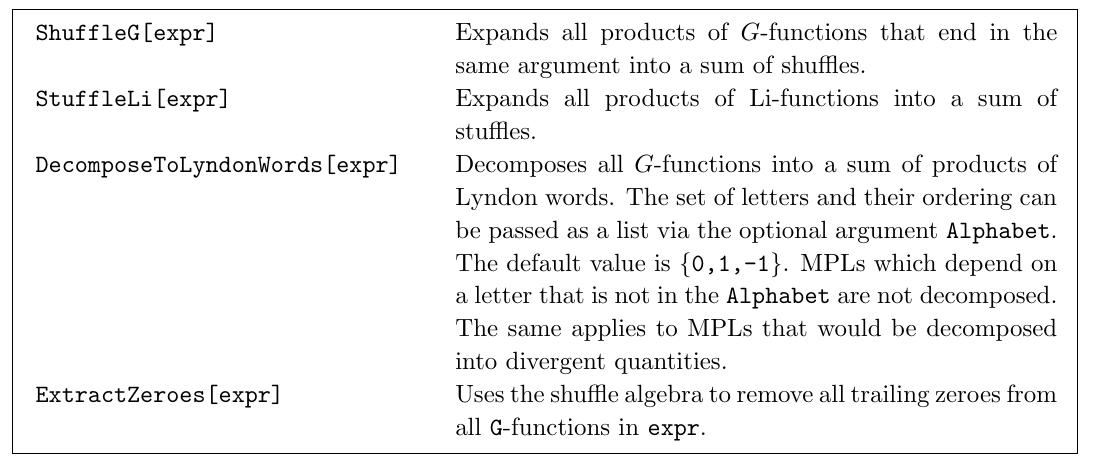
Table 2 . Shu(cid:15)e & stu(cid:15)e